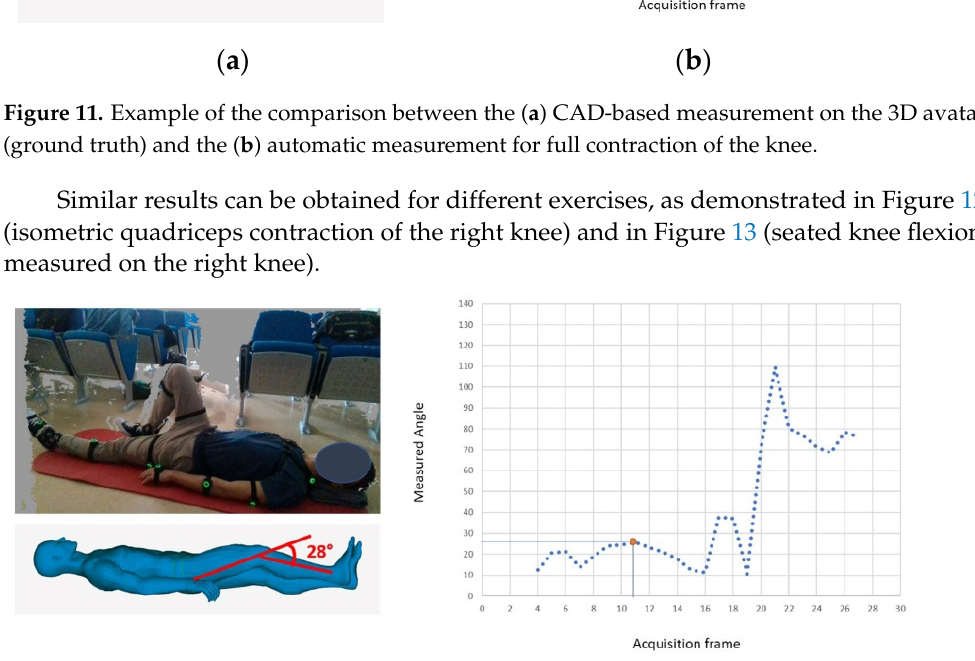
Figure 13. Comparison between the CAD-based measurement on the 3D avatar (ground truth) and the automatic measurement in case of seated knee flection. For testing the system, the physiotherapist performed the measurements 45 times. The measurement of interest angles was performed for the set of 45 repetitions and com- pared to the CAD-based one. The absolute value of the error in identifying the prone hip flexor was 1.05°, with a variance of 0.4°. In the worst case, the measurement error was found equal to 2.23°. Referring to the isometric quadriceps contraction of the right knee, an average absolute error equal to 1.32° with a variance equal to 0.52° was retrieved. For this specific case, the maximum absolute error was found to be 1.73°. Finally, concerning the seated knee flexion, the mean absolute error provided by the automatic measurement was equal to 2.23°, with a variance of 1.43° and a maximum error of 3.21°. These values were considered sufficiently accurate for a home-based measurement by a team of physi- otherapists working at the Villa Olivella Hospital located in Florence (Italy). Furthermore, these results are comparable both to the ones obtained by using 3D-scanner based meas- urements, such as the one proposed in [19] where the relative measurement of knee inter- nal/external rotation (mean (SD)) offset error was 3.4 degrees with a mean RMS error of 1.6°, and to those of IMU-based systems, which have an average error equal to ±3° [20]. From the preliminary results obtained during experimentation, the proposed system allows for complete monitoring of not only the standing output, as recorded in previous similar systems [8], but also of supine exercises, as in the case of actual post-operative rehabilitation. The recorded joint angles show a correct representation of both the exercise repetitions and the corresponding joint angle reached each time, even in the presence of substantial noise signals. The surgeon and/or physiotherapists, to determine whether the patient completes a successful recovery at home or whether any clinicians need to correct or assist him, may review such graphs.